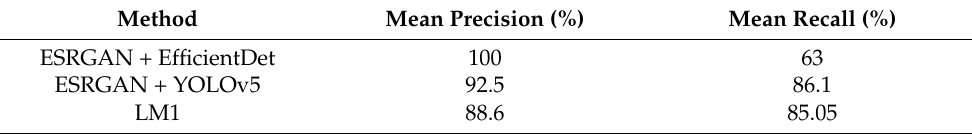
Table 3. Comparative evaluation of the proposed ESRGAN + YOLOv5 and ESRGAN + EfficientDet with Dhiman and Klette [57] best-performing model (LM1) on extracted frames from the PNW dataset.